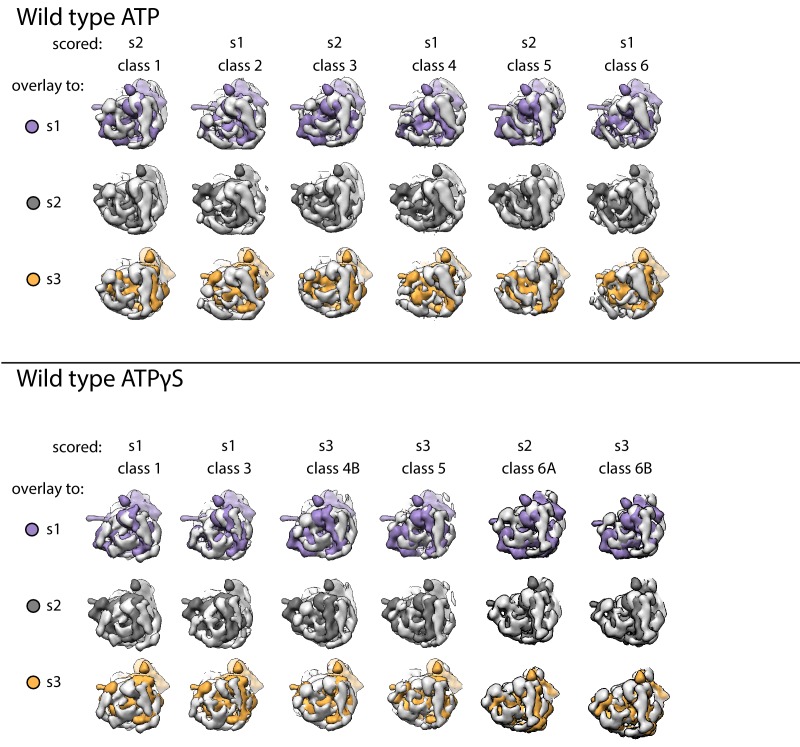
Overlays of each class for wild-type proteasomes to simulated 20 Å maps of s1, s2, and s3 states.Each negative-stain class is shown in light grey and pairwise aligned to the core particles in the 20Å-simulated maps for the s1 (purple), s2 (dark grey), or s3 (orange). Classes were assigned to the scored state based on the best fit of these alignments.